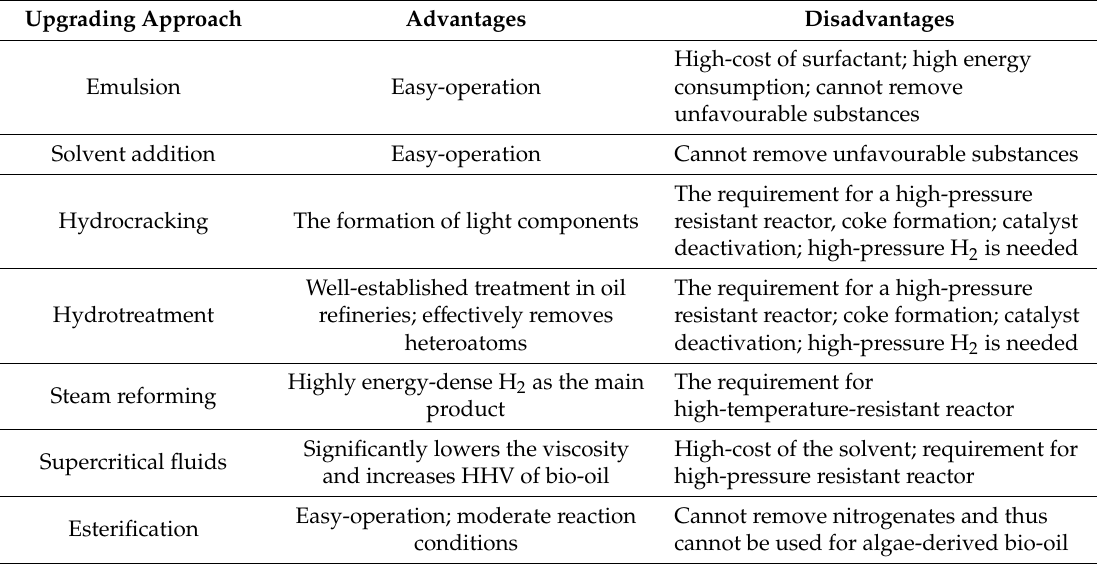
Table 5. An overview of the advantages and disadvantages of various upgrading methods